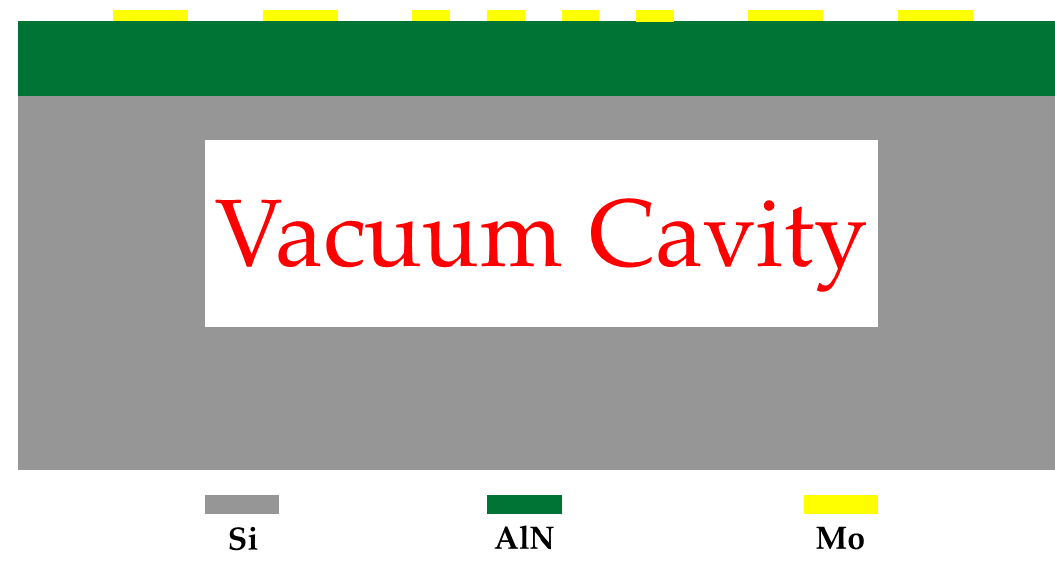
Figure 1. The cross-sectional view of a refreshed acoustic wave pressure sensor design with a deep vacuum cavity.